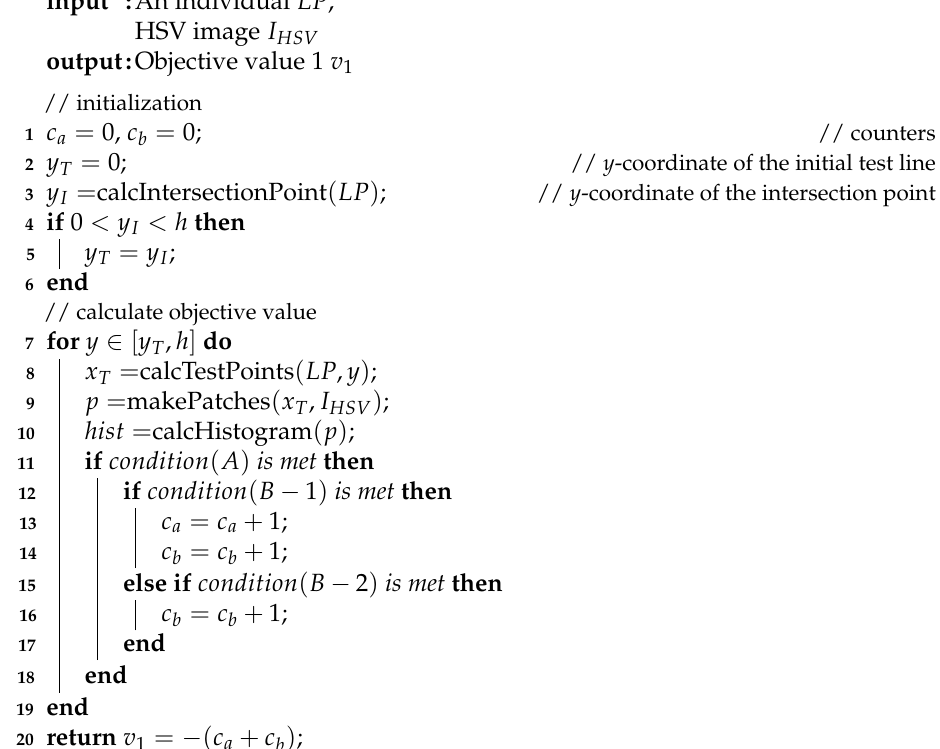
Algorithm 1: Objective Function